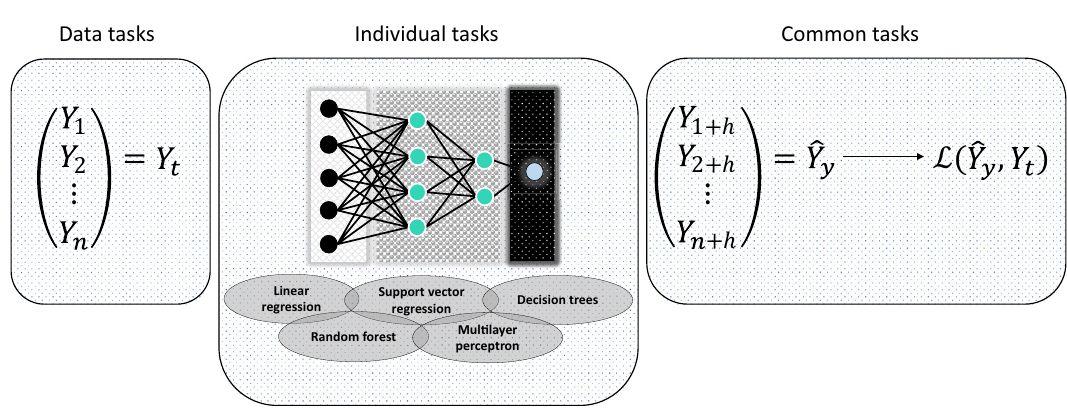
Figure 1. Architecture machine learning: Linear regression, support vector regression, decision trees, random forest, and multilayer perceptron. Data tasks: the data related to the ozone concentration in the winter season of 2017, 2018 and 2019 are organized. Individual tasks: machine learning models are applied to data that was previously organized. Common tasks: the prediction is made and the errors of each model are calculated using performance